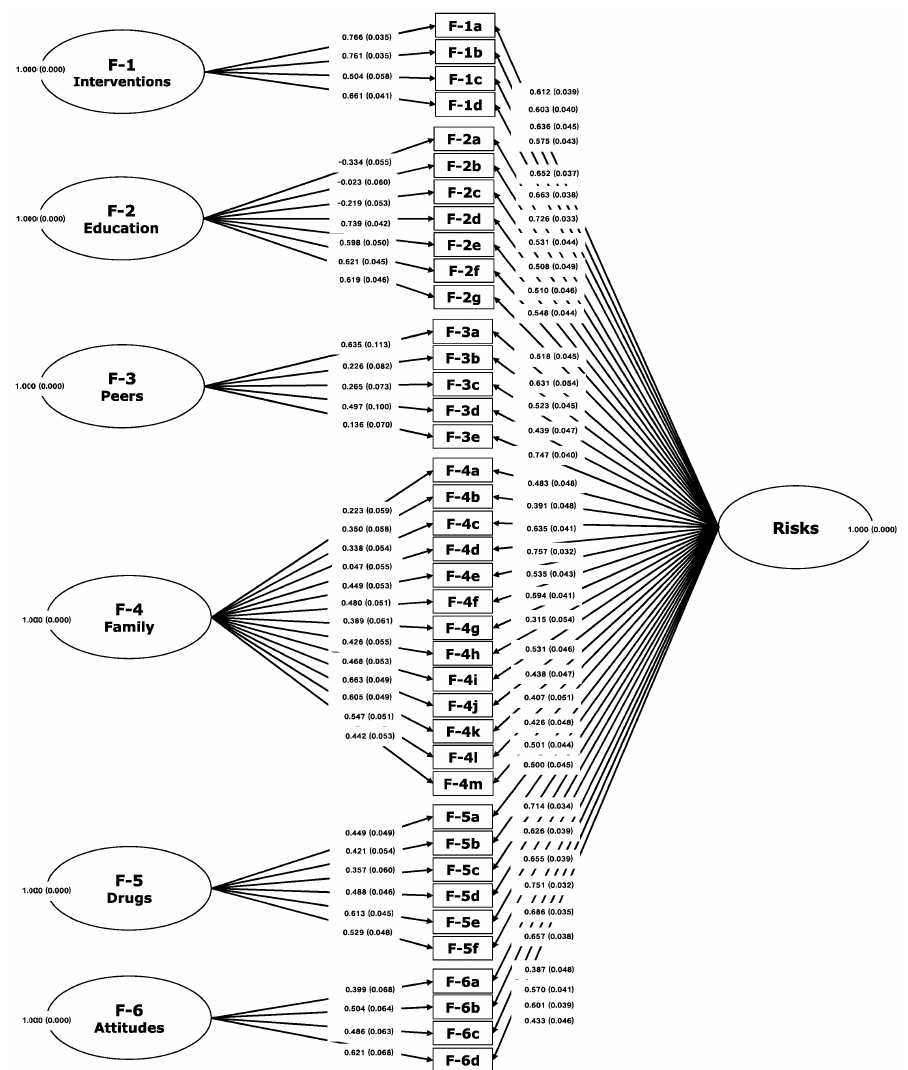
Figure 3. Mapping of confirmatory bifactor analysis of six facets of risks on the